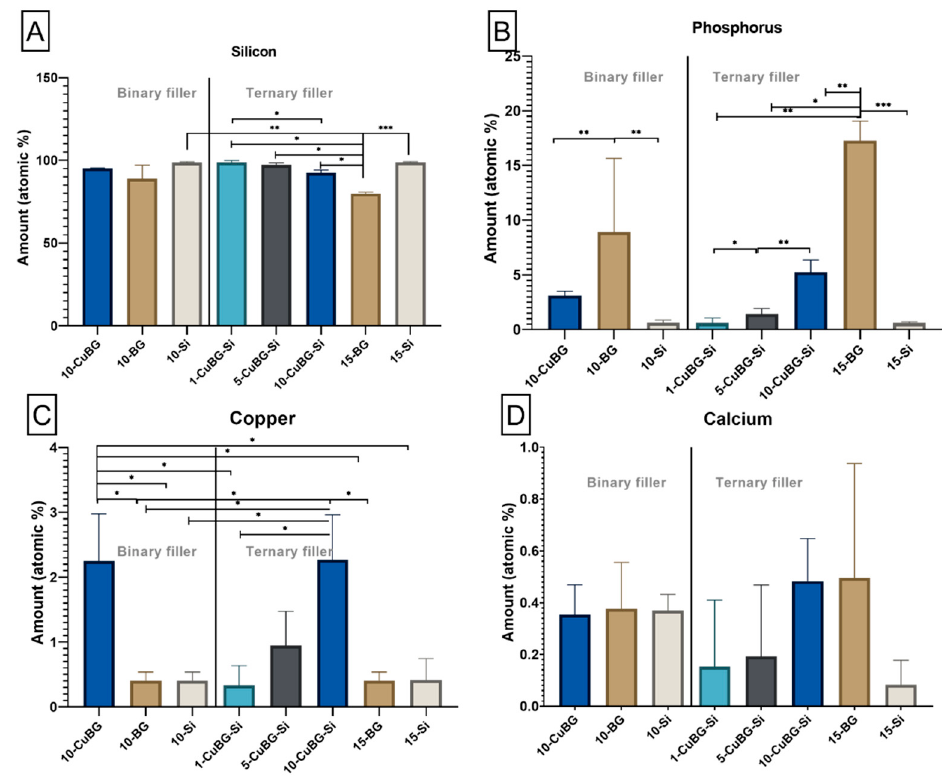
Figure 3. Quantitative analysis of elements is expressed in Figures 1 and 2. The atomic percentage